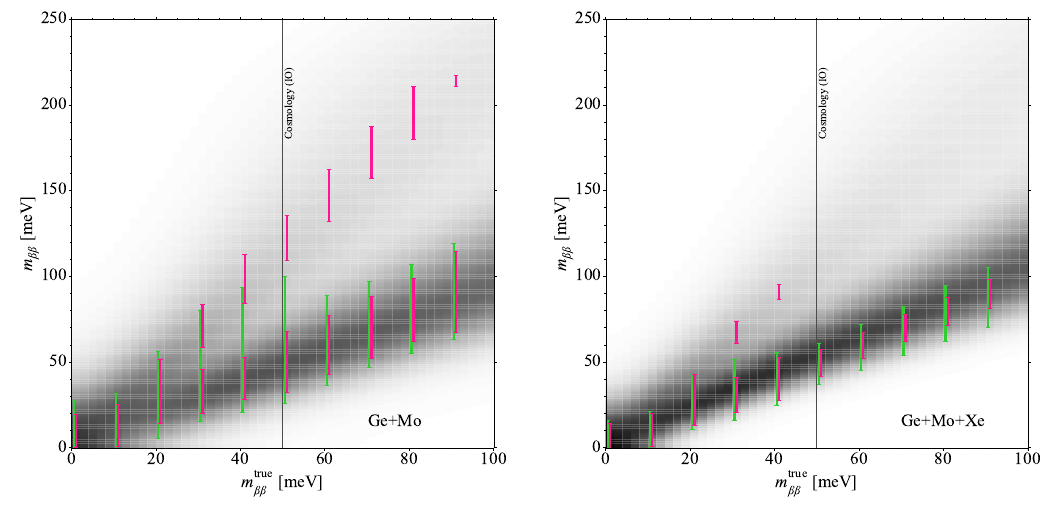
Figure 6 . 68% credible intervals over m ββ for different m true , computed as in the bottom row of ββ figure 5, for our baseline NME probability distribution (green) and a 10-times narrower one (ma- genta) as discussed in the text, in the case of Ge+Mo observation (top) and Ge+Mo+Xe observation (bottom). To illustrate the primary and secondary bands, marginalized posterior distributions are plotted as vertical histograms in